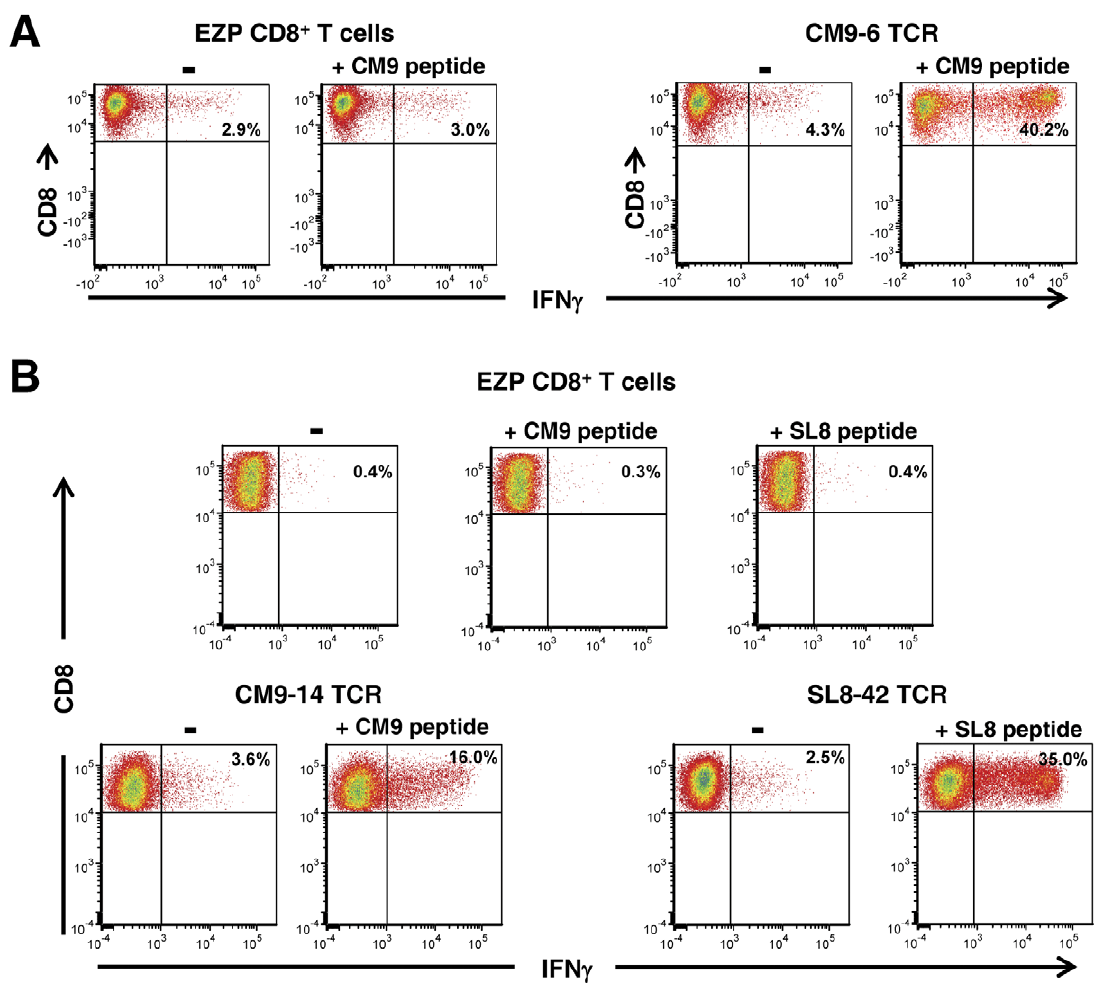
Figure 3. Intracellular IFN c assay of TCR-transduced cell lines. Flow cytometry analysis of intracellular IFN c production induced by the antigenic peptide is presented. Panel A, an assay of the CM9–6 TCR cell line stimulated with the CM9 peptide is displayed with its corresponding untransduced EZP CD8 + T-cell line control. Panel B, an assay of the CM9–14 TCR and SL8–42 TCR cell lines stimulated with either the CM9 or SL8 peptide is presented below their corresponding untransduced CD8 + T-cell controls. The stimulating peptide used is indicated above the respective plots.